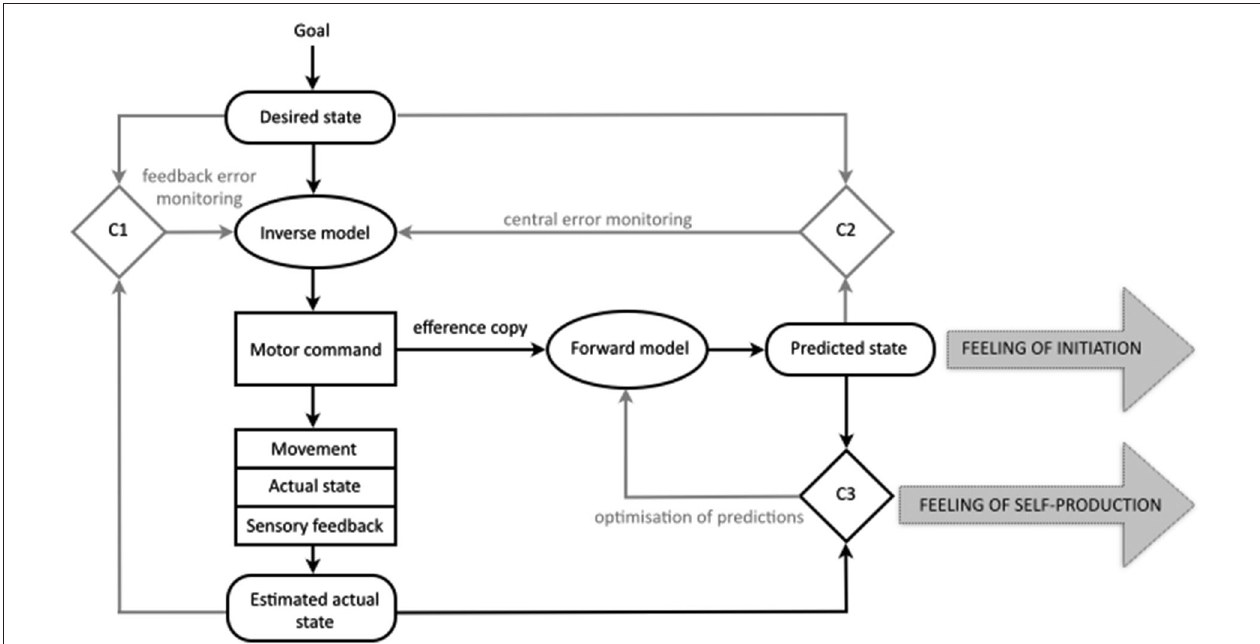
results in a feeling of initiation . Because the predicted state matches the sensory feedback from the new actual state, the comparison in comparator three, gives rise to a feeling of self-production . It is proposed that, in schizophrenia, disruptions to the predicted state lead to abnormalities in both the feeling of initiation and the feeling of self-production for bodily actions (for further details see main text; figure modified after Frith et al., 2000b; Blakemore et al., 2002; Synofzik et al.,